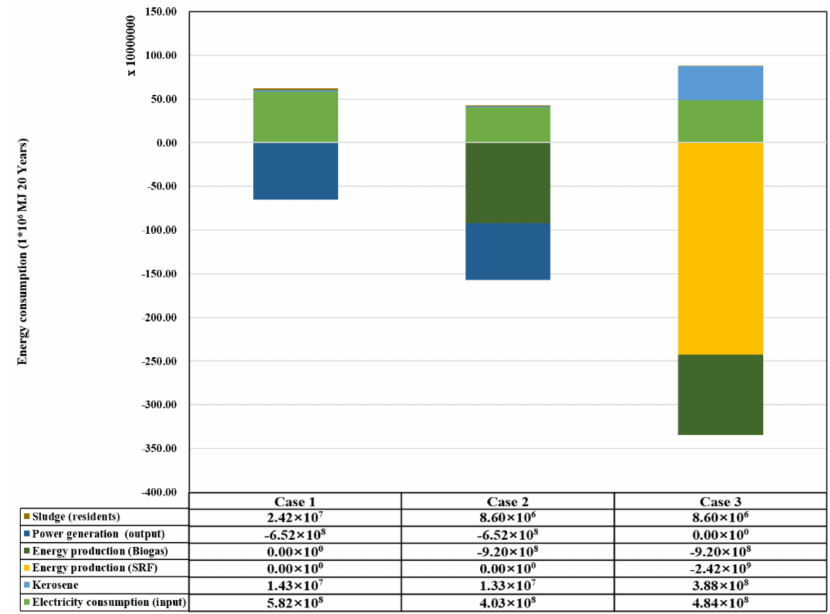
Figure 4. Primary energy consumption of each case.